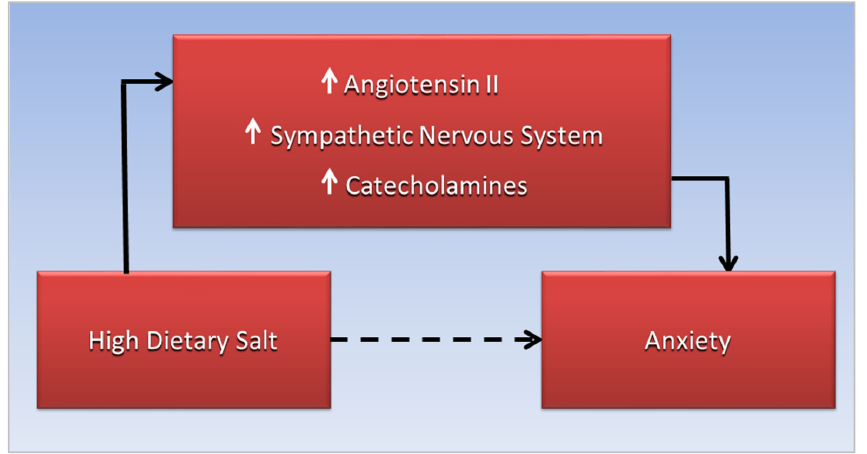
Figure 1. The association of high dietary salt and anxiety, the dotted line, is mediated by increased interaction of angiotensin II with the sympathetic nervous system, leading to increased catecholamine release.